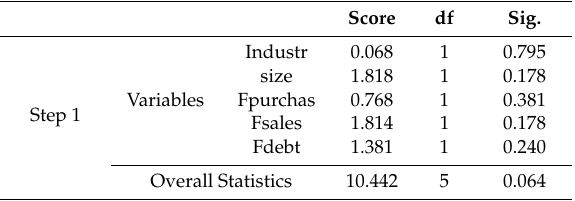
Table A3. The results of the Logistics regression: variables not in the model.